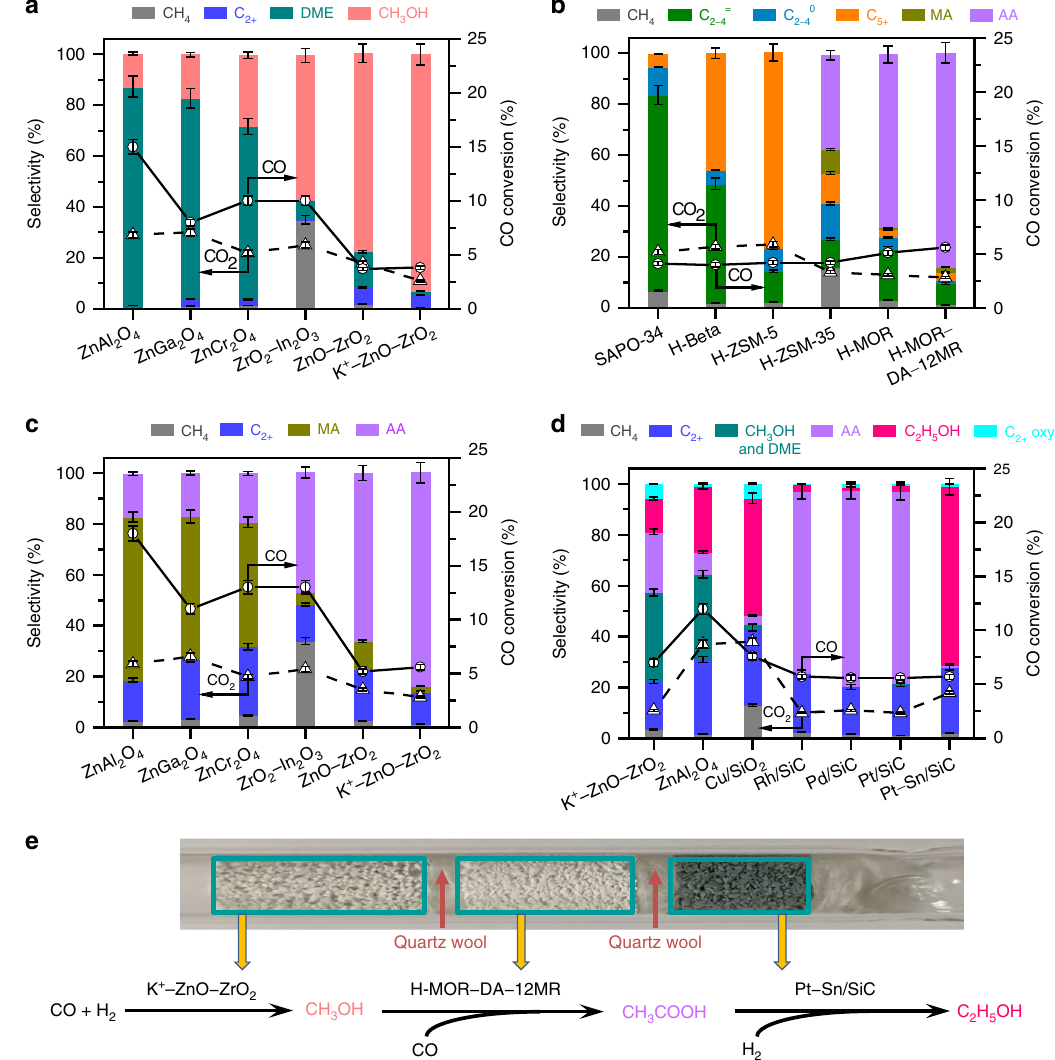
Fig. 2 Catalytic behaviours and reaction pathways. a Metal oxides alone. b Combinations of K + – ZnO – ZrO 2 and zeolites. c Combinations of metal oxides and H-MOR – DA – 12MR. d Combinations of K + – ZnO – ZrO 2 , H-MOR – DA – 12MR and hydrogenation catalysts. e Reaction pathways for direct synthesis of ethanol from syngas. C 2 + : C 2 + hydrocarbons; DME: dimethyl ether; C 2 – 4 = : C 2 – C 4 ole fi ns; C 2 – 4 0 : C 2 – C 4 paraf fi ns; C 5 + : C 5 + hydrocarbons; MA: methyl acetate; AA: acetic acid; C 2 + oxy.: ethyl acetate and methyl acetate. Reaction conditions: weights of metal oxide, zeolite and hydrogenation catalyst = 0.66, 0.66 and 0.66 g; H 2 /CO = 1:1; P = 5.0 MPa; T = 583 K; F = 25 mL min − 1 ; time on stream, 20 h. The selectivity was calculated on a molar carbon basis. Carbon balances were 95 – 99%. The experiments in each case were performed for three times. The error bar represents the relative deviation, which is within